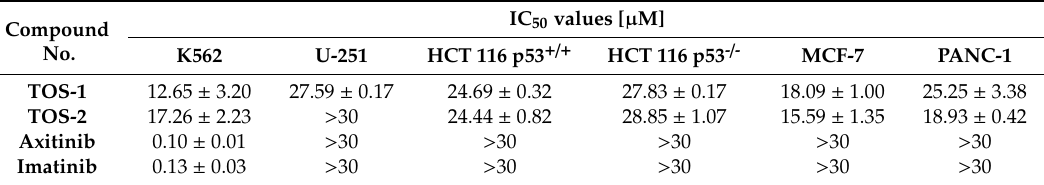
Table 2. The antiproliferative activity of the tested IDH1 inhibitors compared to axitinib and imatinib in several tumor cell lines.